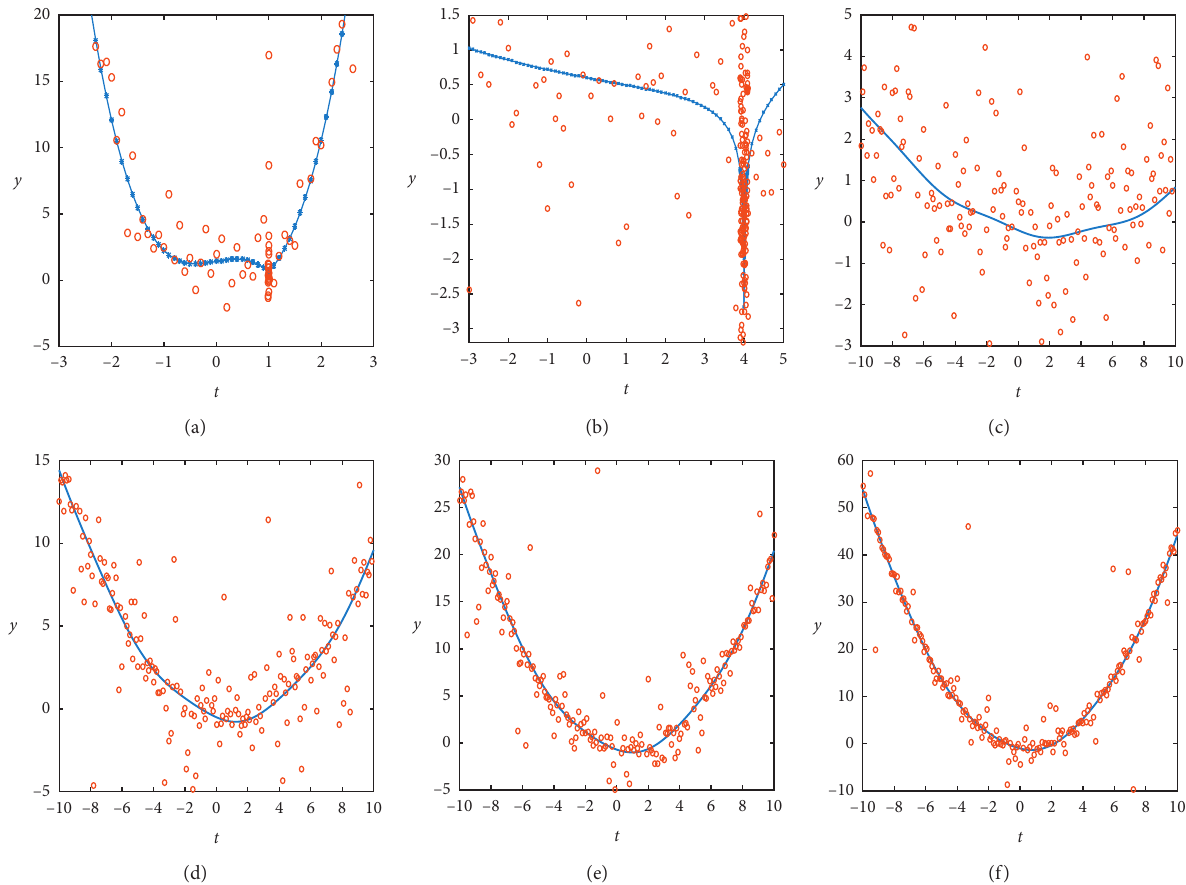
� √ 2 . (b) Model 2, θ � 2.